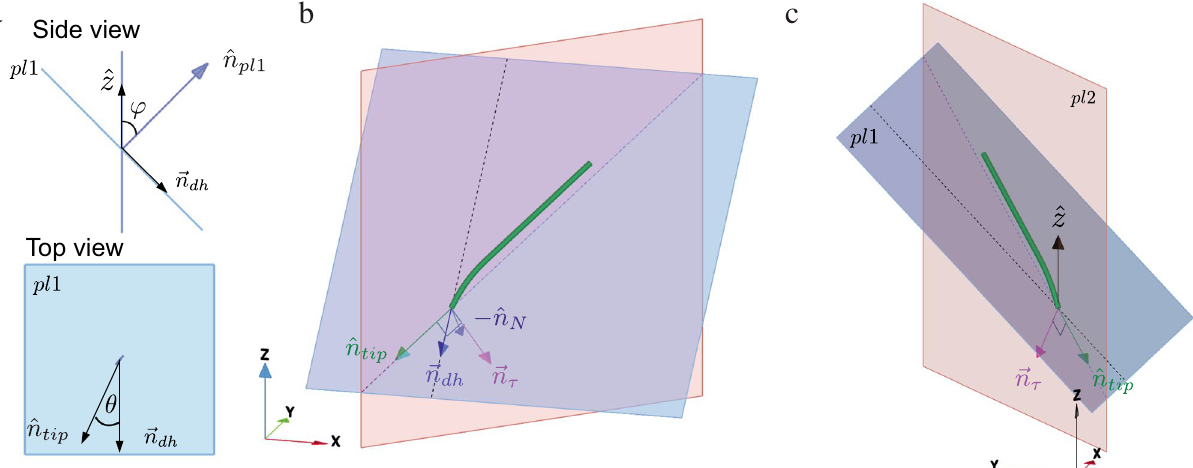
Figure 6. Symmetry breaking: ( a ) Top: a side-view of the plane representing the substrate plane and its normal vector ˆ n pl 1 (in blue). Bottom: top view of pl 1 showing the angle θ between ˆ n tip and (cid:31) n dh . ( b ) The FMZ (green cylindrical object) and the vectors representing the tip direction ˆ n tip , the downhill direction ˆ n dh , the negative to the normal direction −ˆ n N , and the direction at which force is being applied to the gel (cid:31) n τ . The dashed line represents the downhill direction. The bending of the green cylinder represents the bending of the FMZ inside pl 2. ( c ) Same as ( b ) but from a different viewing angle. Note that the coordinate axes rotate with the different perspectives and are different from the one used in Fig.